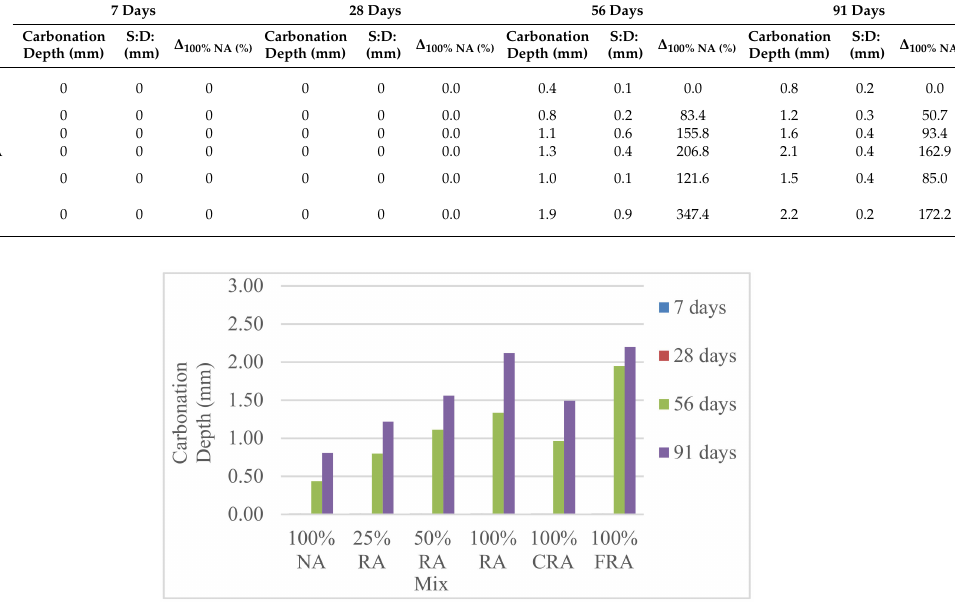
Figure 17. Carbonation test results at 7, 56, 28 and 91